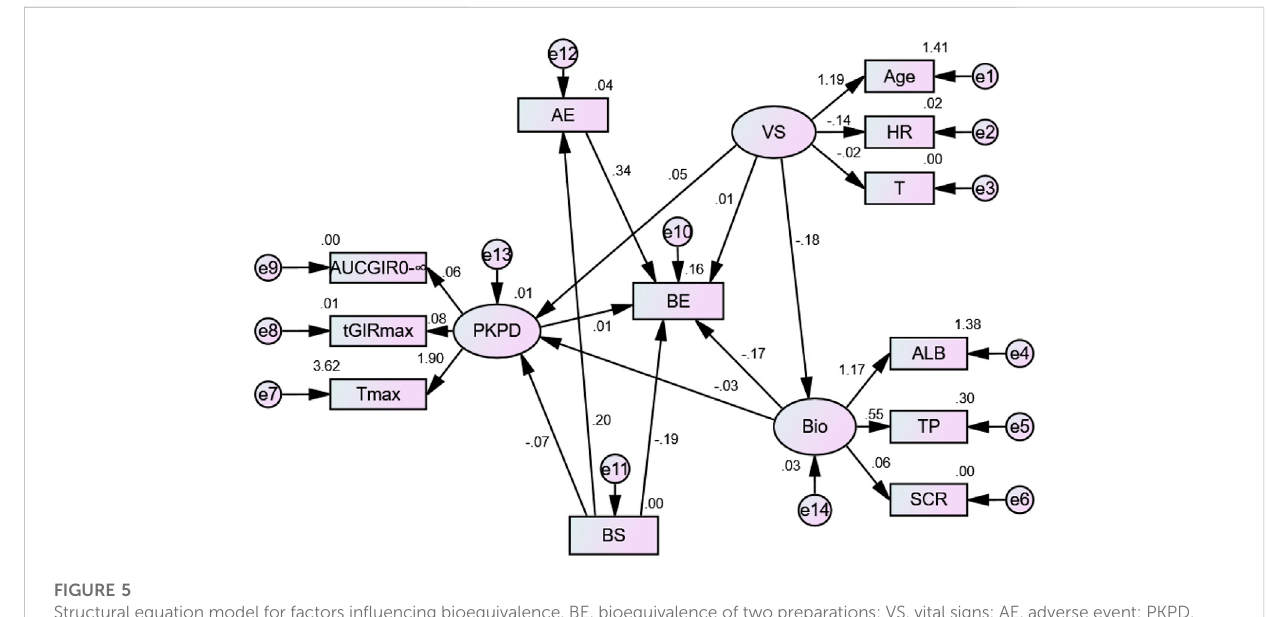
FIGURE 5 Structural equation model for factors in fl uencing bioequivalence. BE, bioequivalence of two preparations; VS, vital signs; AE, adverse event; PKPD, pharmacokinetic and pharmacodynamic parameters; BS, bioactive substance content; Bio, biochemical parameters; represents the explicit variable; represents the latent variable; and “ e ” represents the errors.